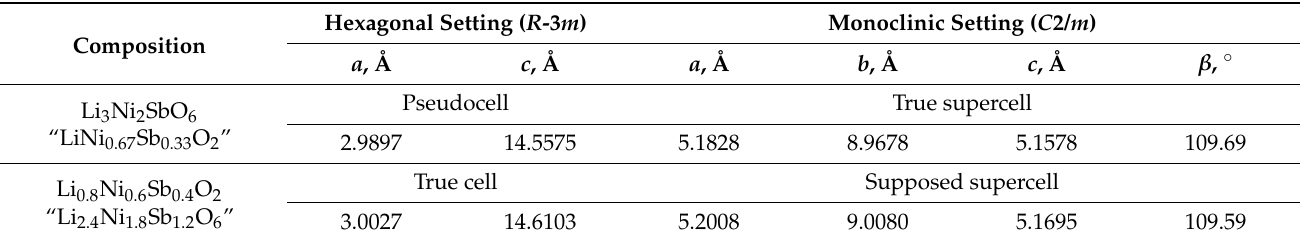
Table 1. Crystal lattice parameters of Li 3 Ni 2 SbO 6 and Li 0.8 Ni 0.6 Sb 0.4 O 2